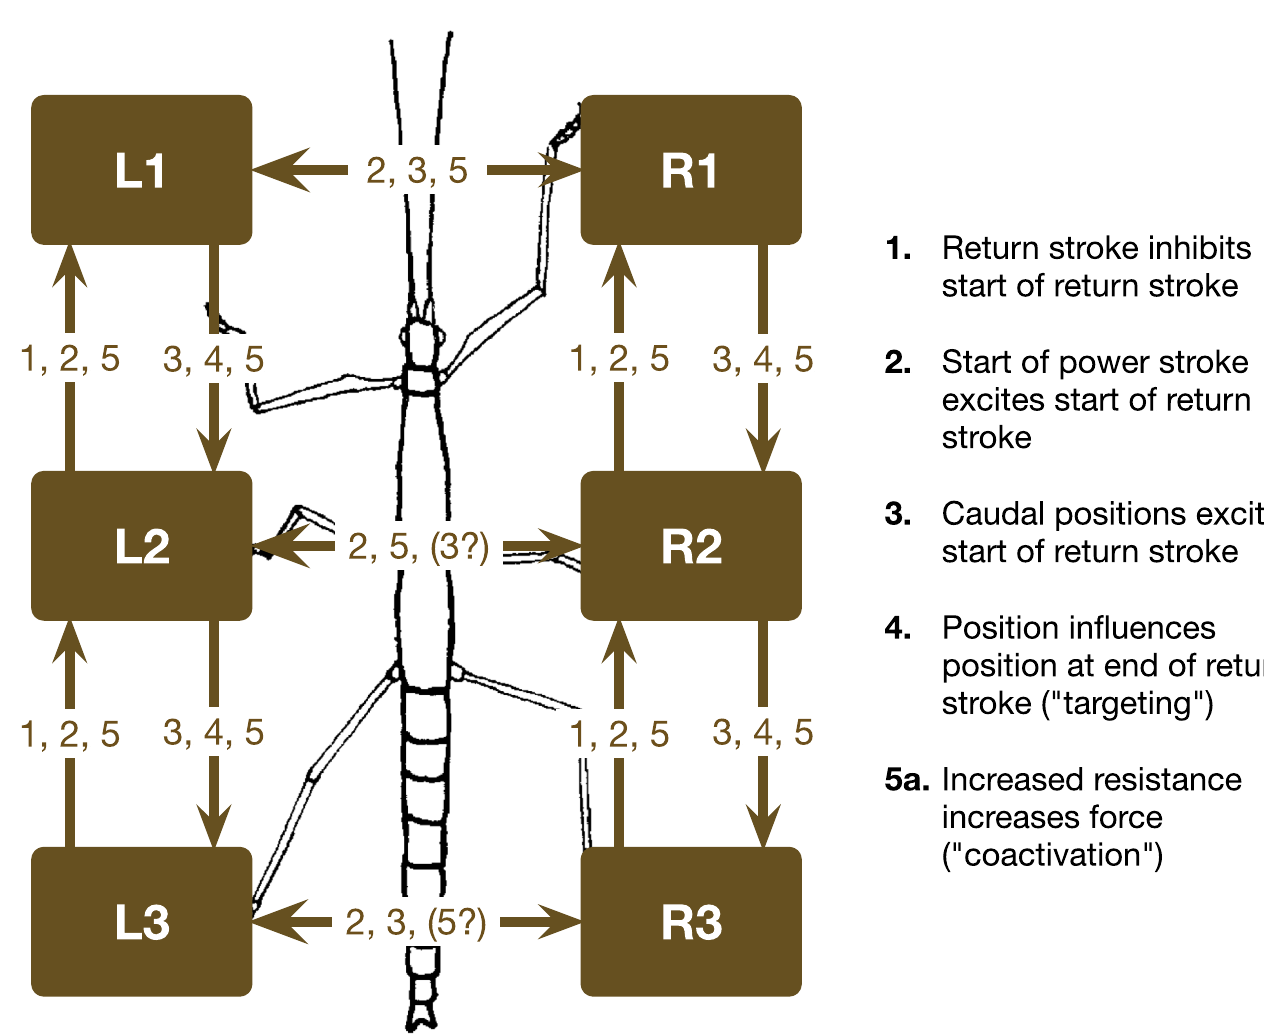
Fig 12. Single leg controllers (shown in brown) and their connection via coordination rules (from [15]). L1, L2, L3 left front, middle, and hind leg, respectively. R1, R2, and R3 stand for the corresponding right legs. The question mark indicates that there are ambiguous data concerning influence